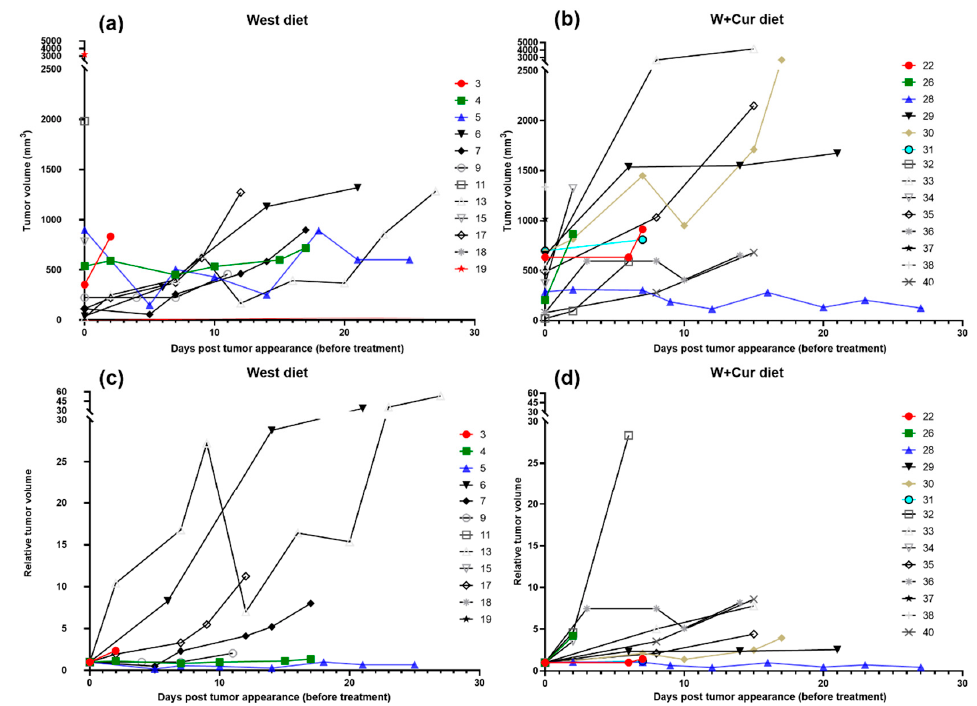
Figure 3. Individual tumor growth curves showing absolute ( a , b ) and relative ( c , d ) tumor volumes over days post tumor appearance but before treatment start: ( a , c ) West diet, ( b , d ) W + Cur diet. The tumor volumes were normalized with the tumor volume at inception to calculate the relative tumor volume.